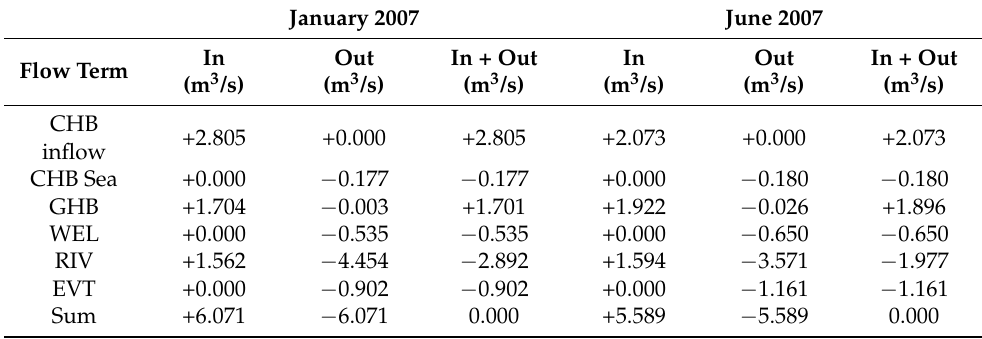
Table 3. Components of the hydrogeological balance as calculated in the flow